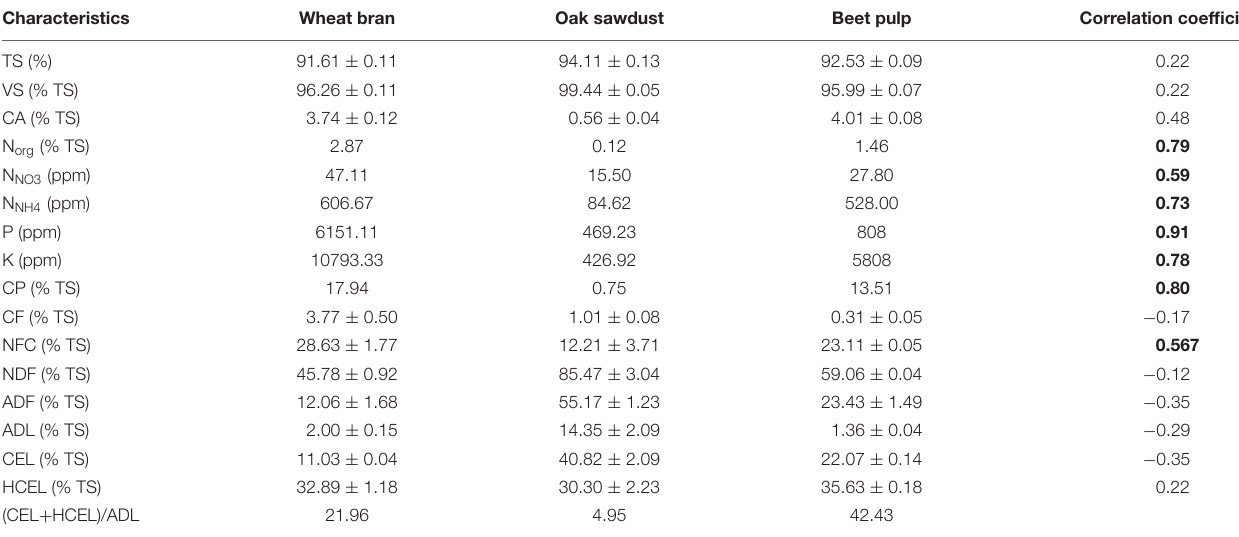
TABLE 1 | Chemical properties of tested